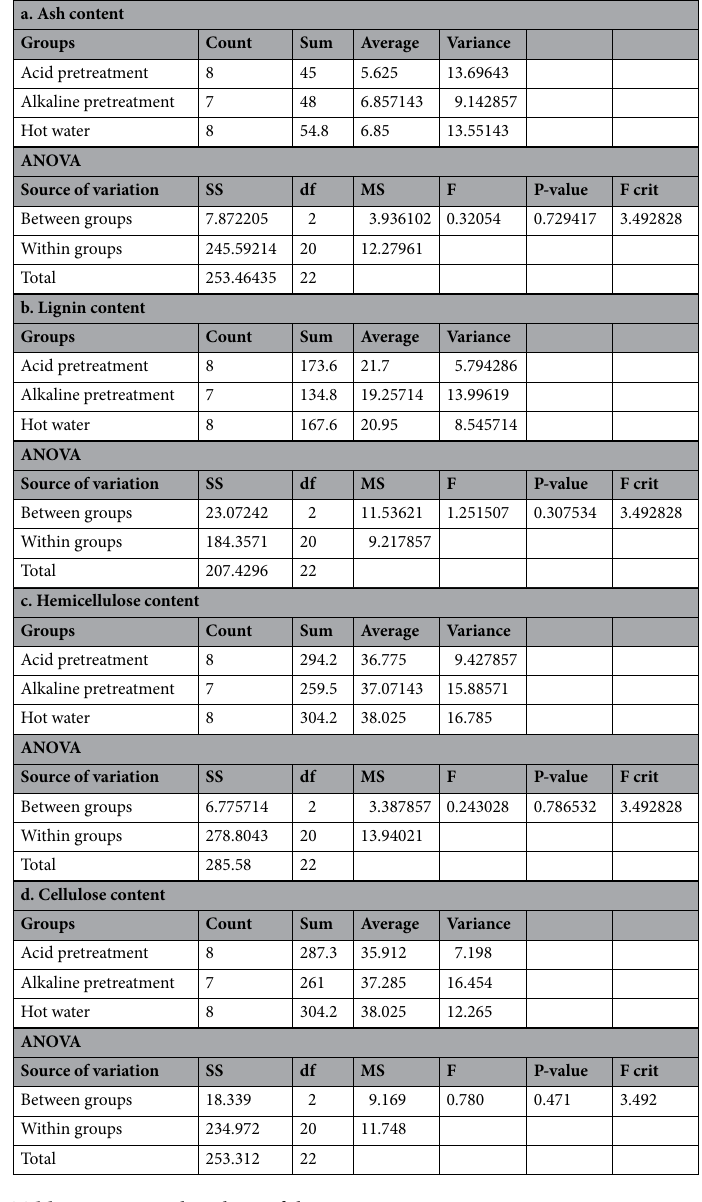
Table 5. Statistical analysis of the pretreatment parameters.